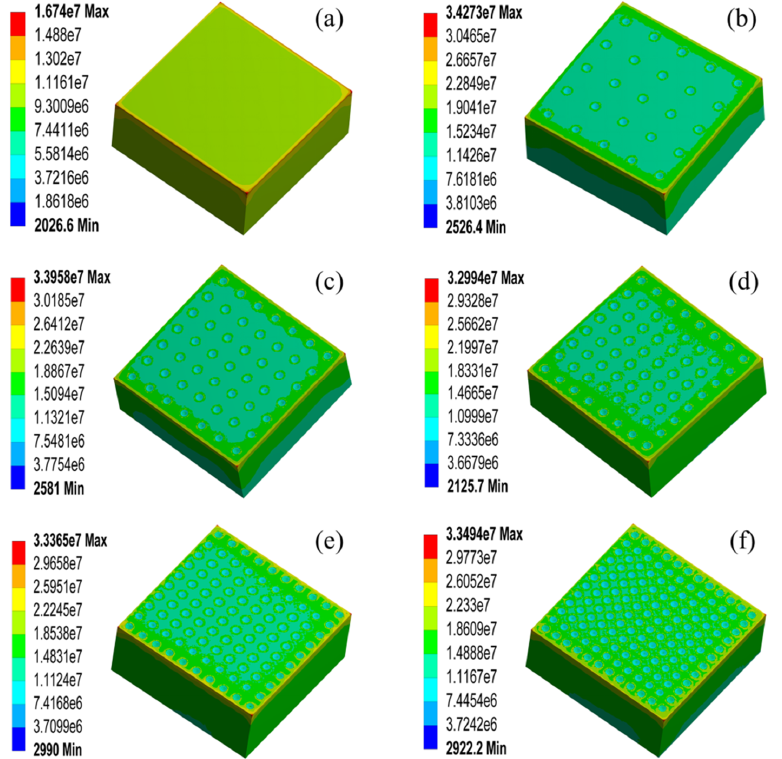
Figure 12. The equivalent stress distributions of the specimens with different texture densities: ( a ) smooth, ( b ) texture density = 4%, ( c ) texture density = 8%, ( d ) texture density = 13%, ( e ) texture density = 18%, and ( f ) texture density = 30%.